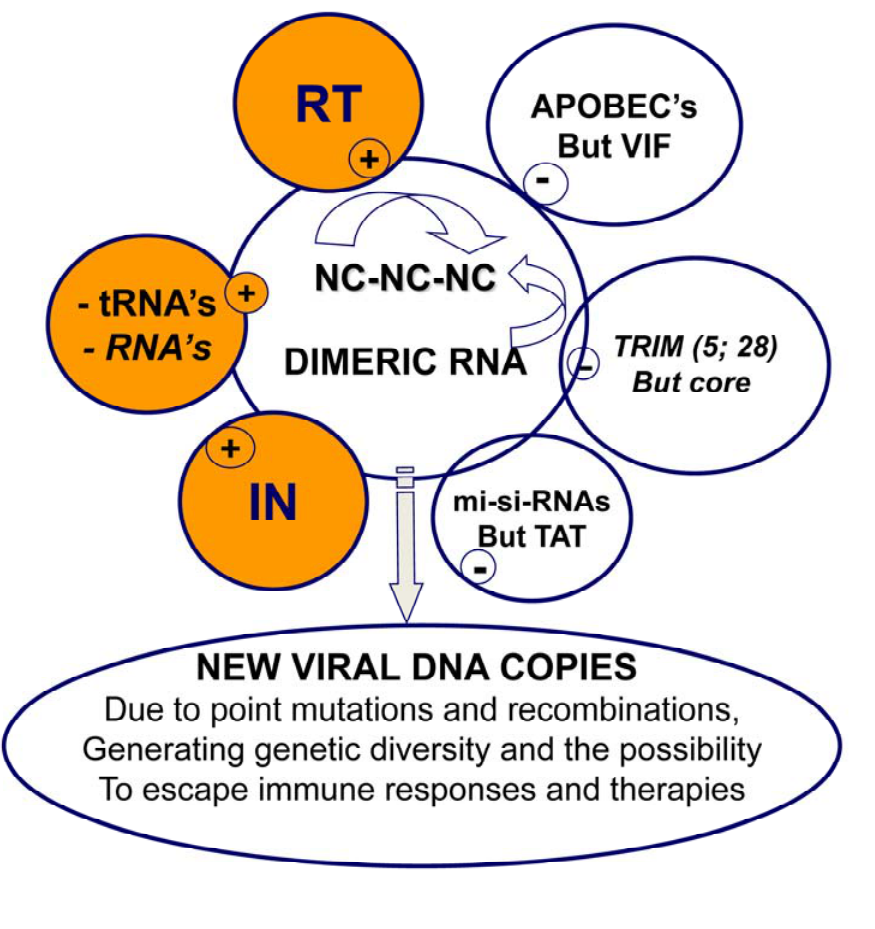
Figure 4. Molecular interactions in the course of reverse transcription. This scheme illustrates essential molecular interactions taking place prior to and during reverse transcription. (i) The genomic RNA is in a dimeric form where there are many RNA-RNA interactions, in addition to the Dimer Linkage Structure (DLS). (ii) Several hundred NC molecules, in a poorly characterized oligomeric form [72] (see top arrow pointing to NC- NC interactions), coat the genomic RNA providing protection against cellular nucleases and UV irradiation; (iii) A number of small cellular RNAs are incorporated into virions via interactions with Gag-NC and Pol-RT and Pol-IN (not illustrated here); except for the primer tRNA the function, if any, of the other cellular RNAs is poorly understood. (iv) The RT and IN enzymes interact with the genomic RNA-NC complex ensuring reverse transcription and ultimately integration of the newly made viral DNA. (v) In the absence of the viral factor VIF, APOBEC restriction factors are incorporated into virions via interactions with the viral RNA and NC, which results in the production of highly mutated viral DNA molecules. (vi) The reverse transcription machinery is housed within the incoming virion core where capsid protein molecules provide protection against host restriction factors such as TRIM proteins (see also text). (vii) Small amounts of the viral transactivator TAT have been found in the virion core. Tat may counteract the negative impact of cellular miRNA on the stability of the viral RNA prior to virion formation